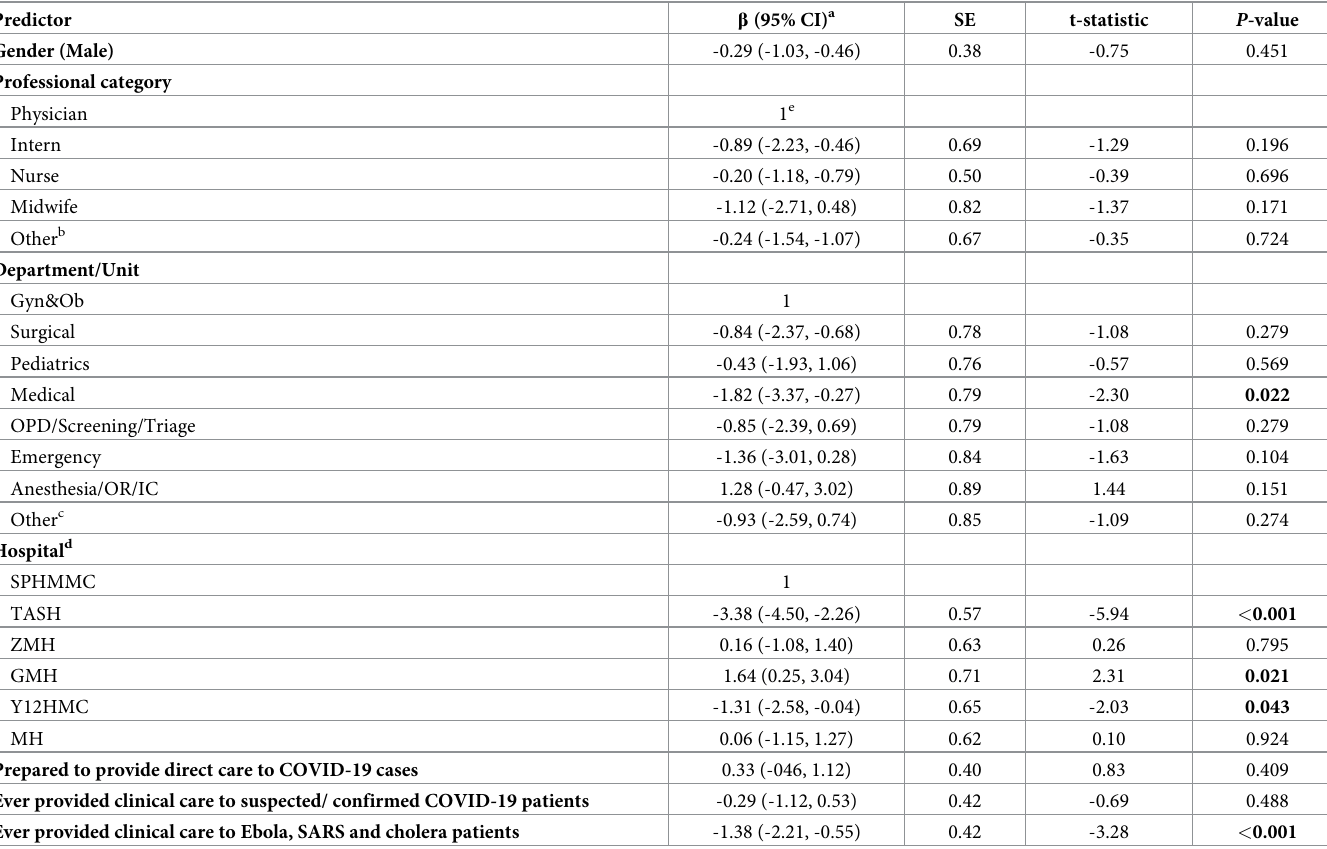
Table 6. Standardized linear regression beta-coefficients ( β ) of predictors associated with worry scores of COVID-19 crisis (n = 952).